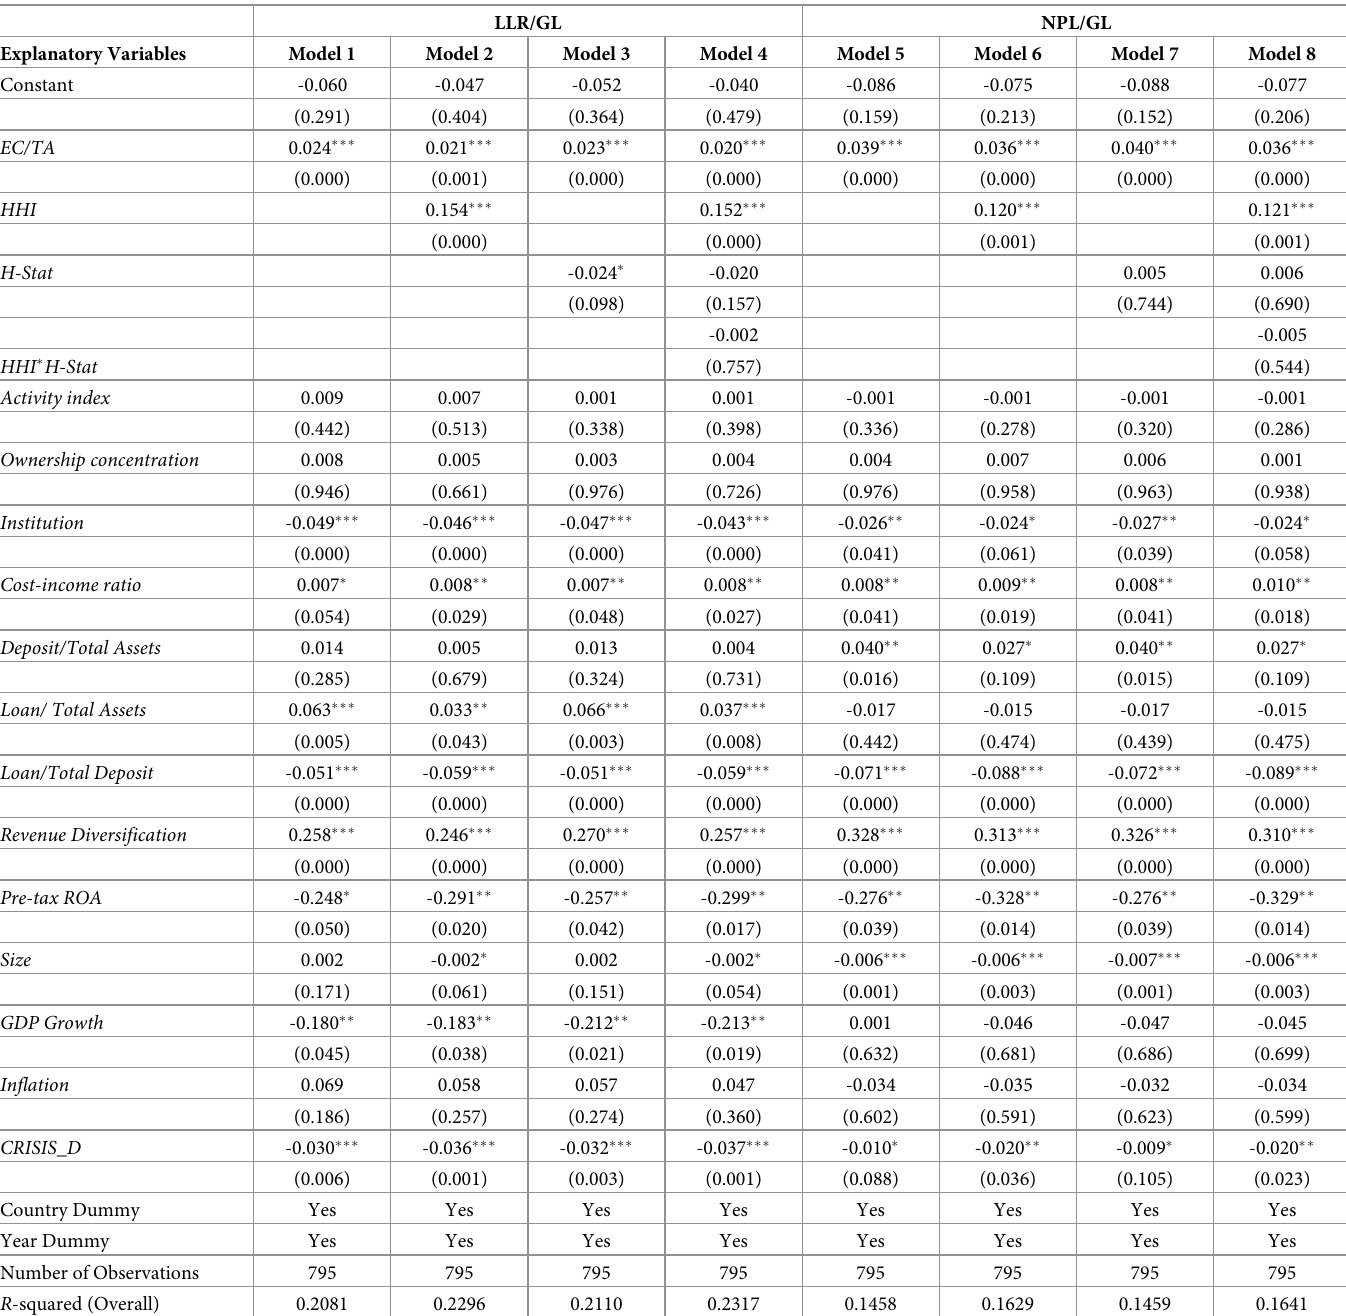
Table 8. Panel regressions of competition and credit risk (IBs,